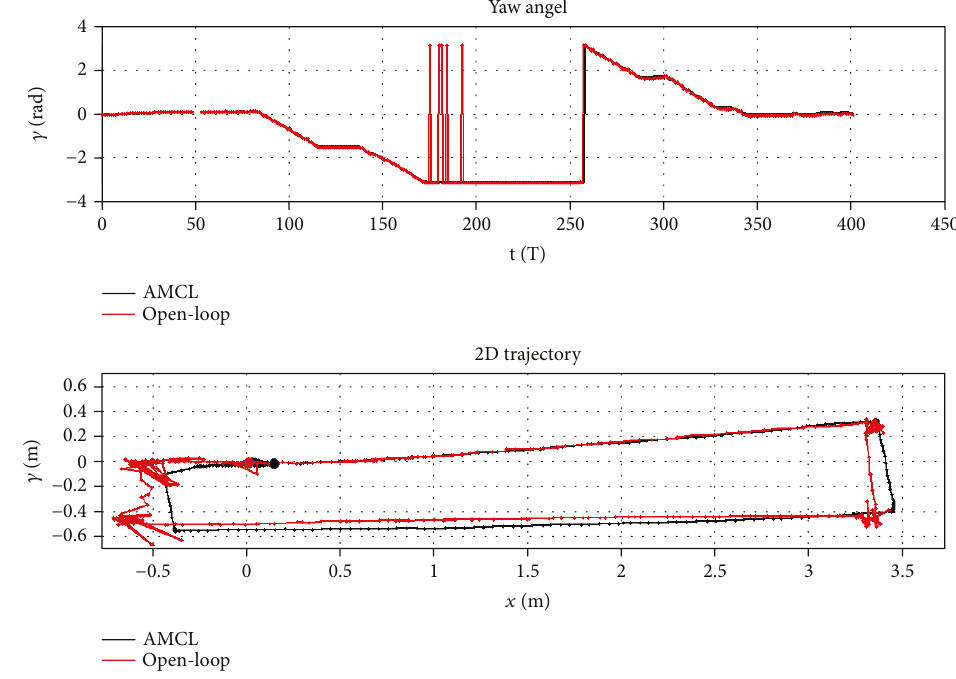
Figure 11: Trajectory of closed-loop motion experiment (open-loop version). Table 3: Result of closed-loop motion experiments